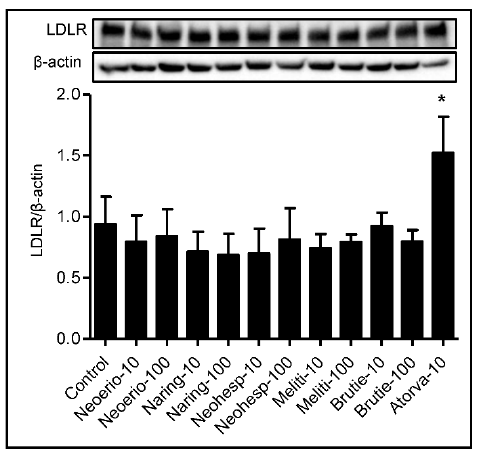
Figure 5. Effect of BFE principal components on protein expression of the LDL receptor. HepG2 cells were treated with indicated concentrations of BFE principal components for 24 h. After treating cells, we performed Western blot for the LDL receptor and β-actin. The intensity of the LDL receptor band was densitometrically measured and normalized to the protein expression level of β-actin. Results are from five independent experiments and expressed as the mean values ± SE. *: p < 0.05 compared with control group.